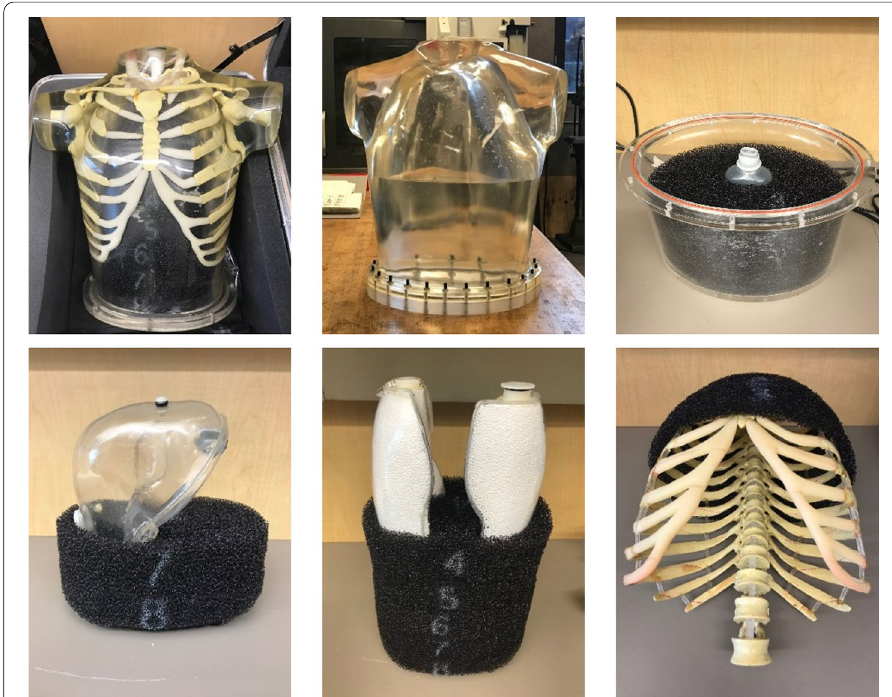
Fig. 1 Anthropomorphic Probe-IQ Phantom. (Top) Left to Right: medium phantom shell, large phantom shell, pelvis shell with bladder insert. (Bottom) Left to Right: liver, lung inserts, ribs and spine that can be inserted in the large